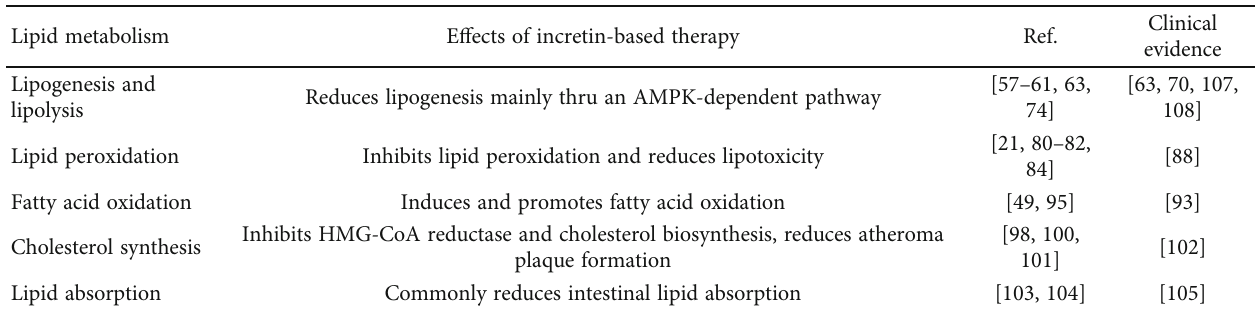
Table 2: The impact of incretin-based medications on lipid